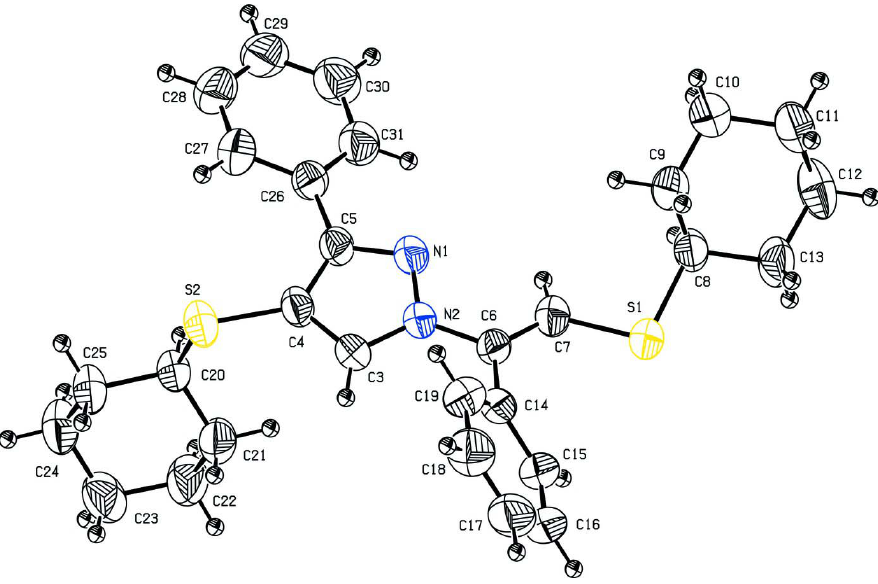
Perspective view of the molecule with thermal ellipsoids drawn at the 50% probability level. H atoms are shown as small circles of arbitrary